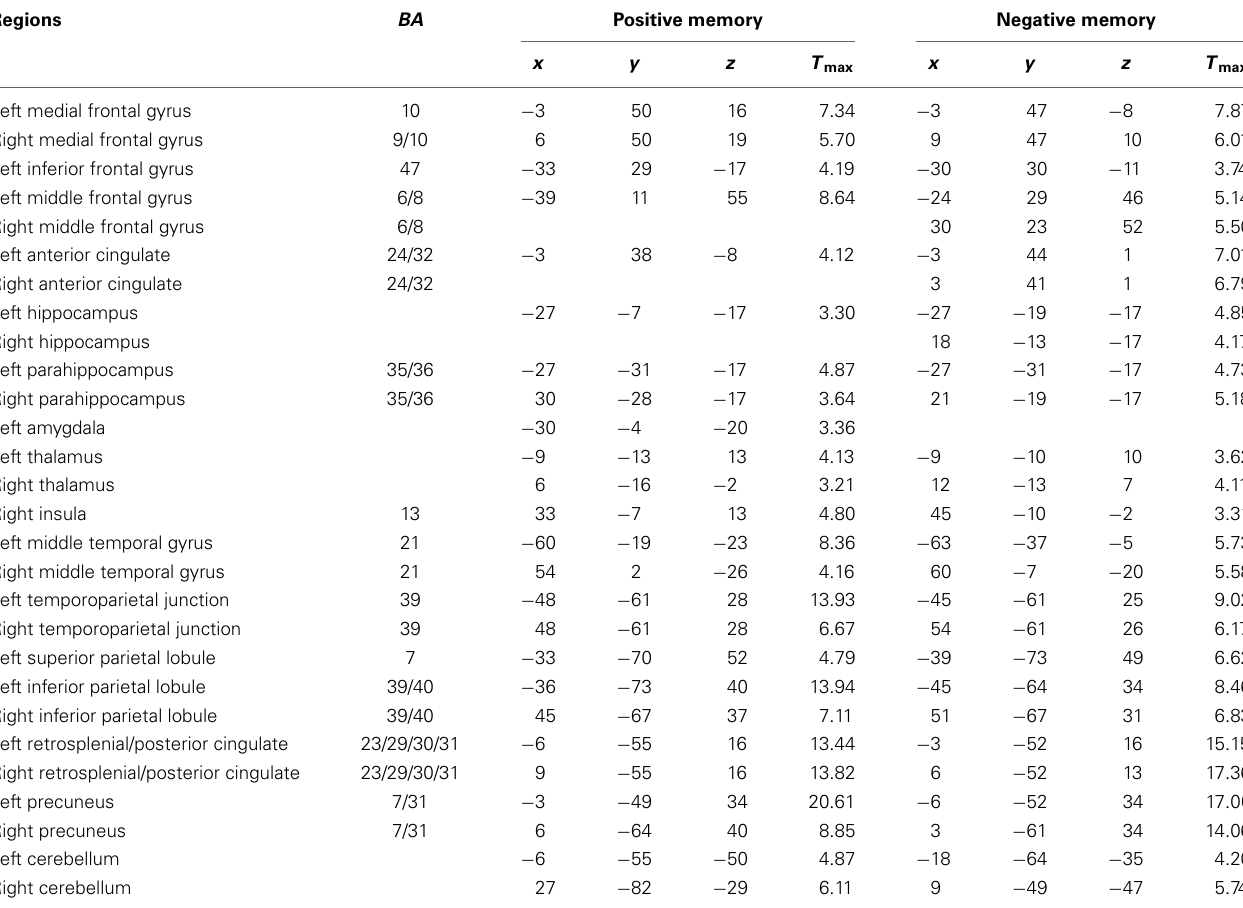
Table 1 | Activated brain regions of the components associated with the positive and negative autobiographical memory tasks for older adults. Regions BA Positive memory Negative